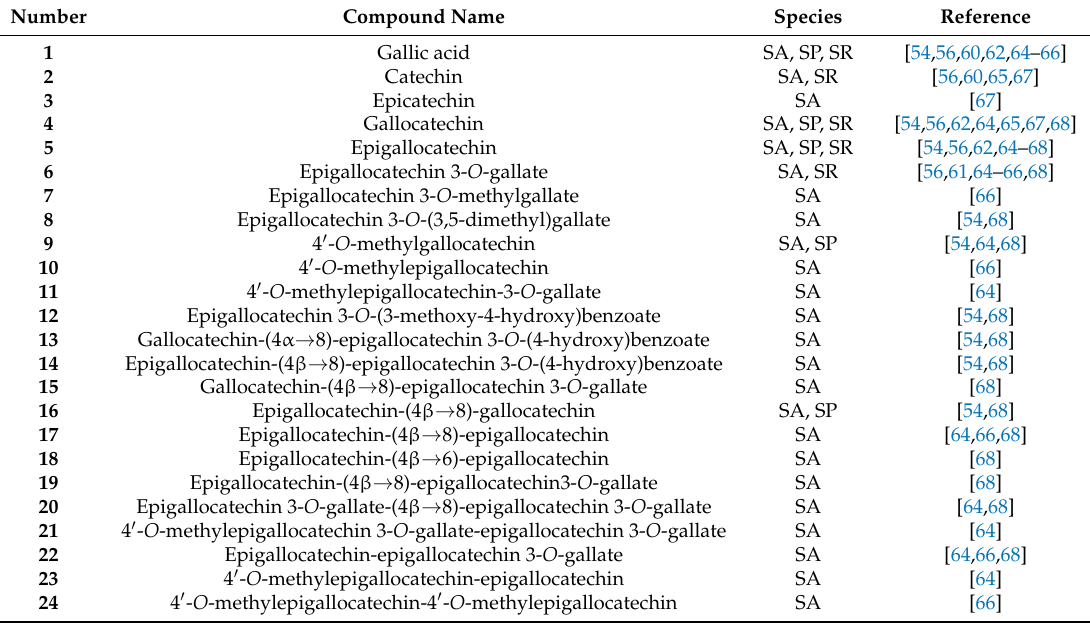
Table 2. Compounds identified in the stem bark of Stryphnodendron species known as “barbatim ã